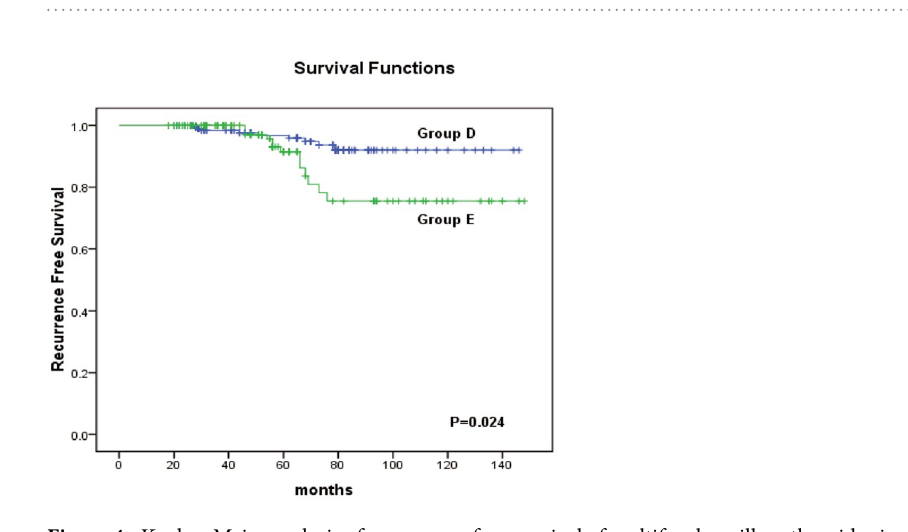
Figure 4. Kaplan-Meier analysis of recurrence-free survival of multifocal papillary thyroid microcarcinoma with a total tumour diameter (TTD) of ≤ 1 cm (group D) and multifocal papillary thyroid microcarcinoma with a total tumour diameter (TTD) of > 1 cm (group